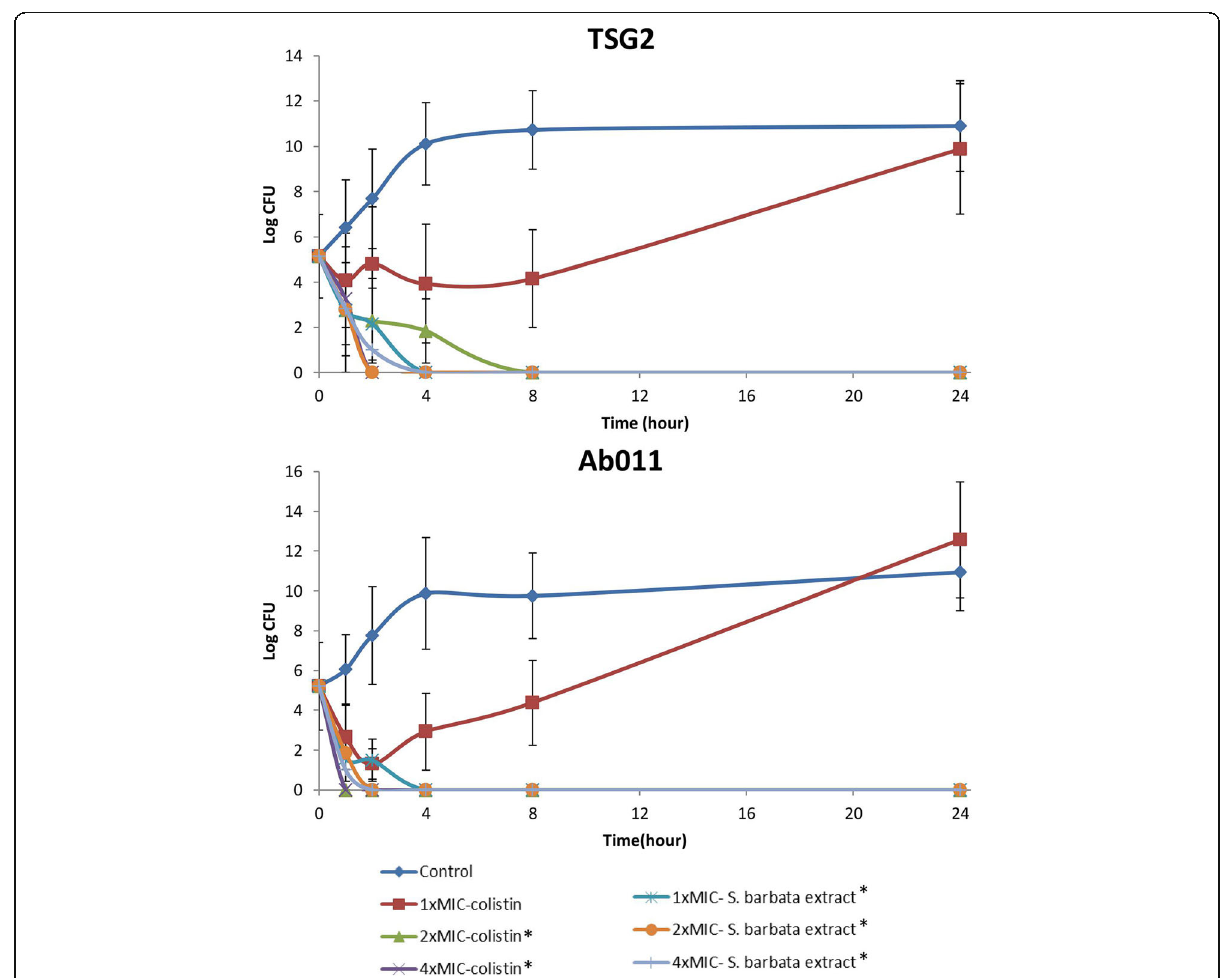
Fig. 2 Time-killing curves of colistin and S. barbata extract assayed on two selected strains of A. baumannii TSG2 and Ab011. “ * ” Significantly lower bacterial load compared to the control group at 24 h ( P < 0.05). n = 3 per